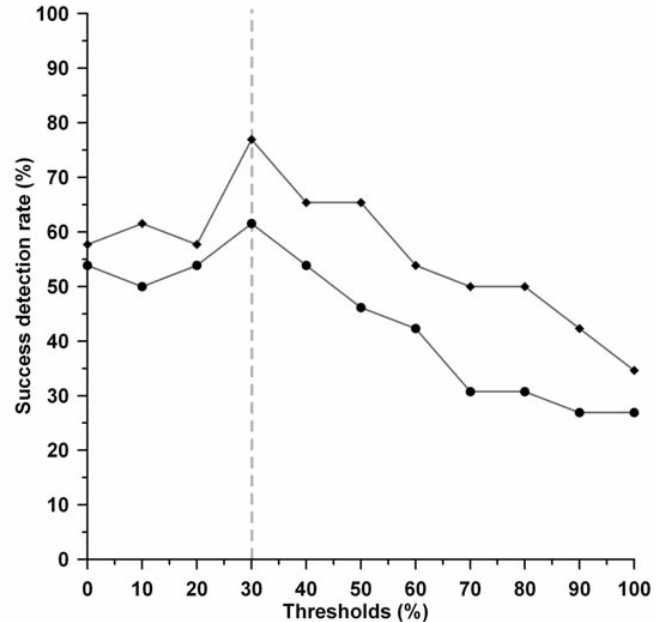
Figure 6. The success detection rate versus the thresholds. Solid circles and diamonds indicate the relationships between the success detection rate and distinct thresholds using the epicenter or the SMART references,